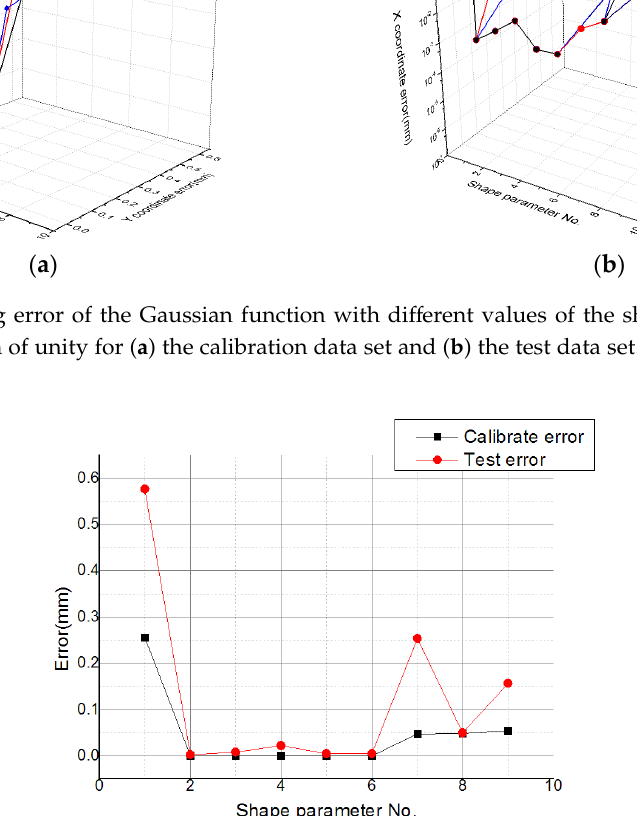
Figure 14. Calibration errors and test errors with different values of the shape parameter.